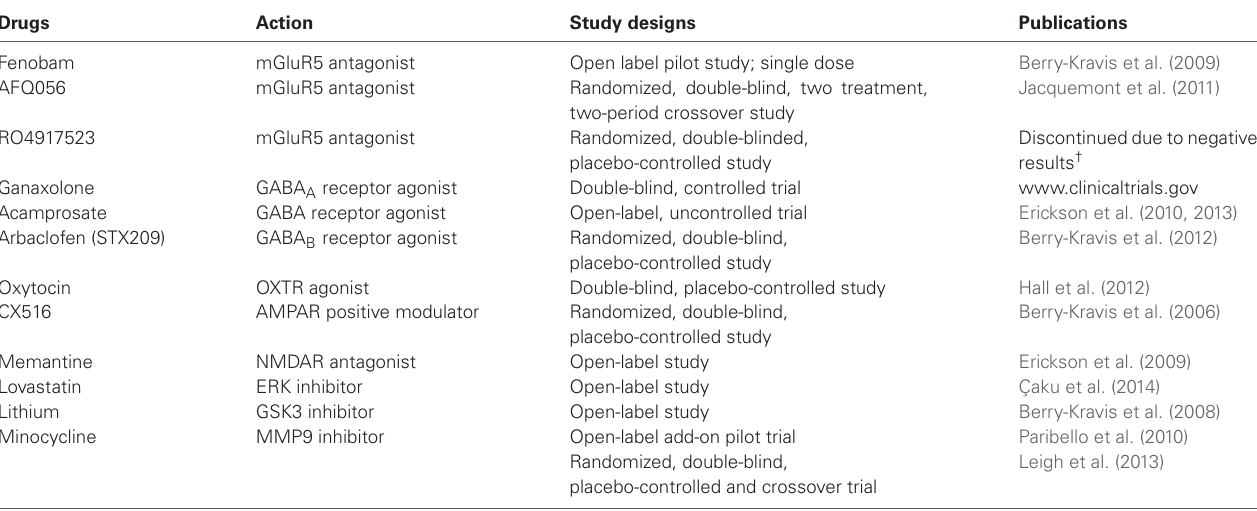
Table 2 | Drugs in clinical trials of fragile X syndrome